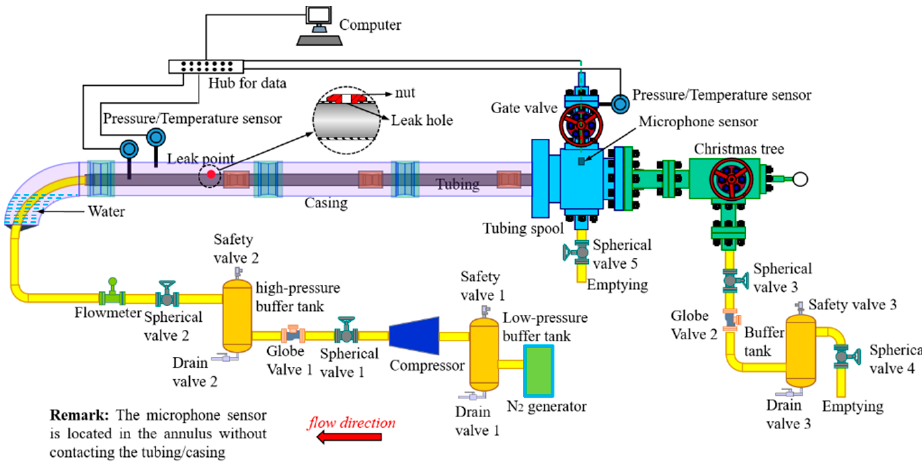
Figure 6. Structure chart of the experimental system.